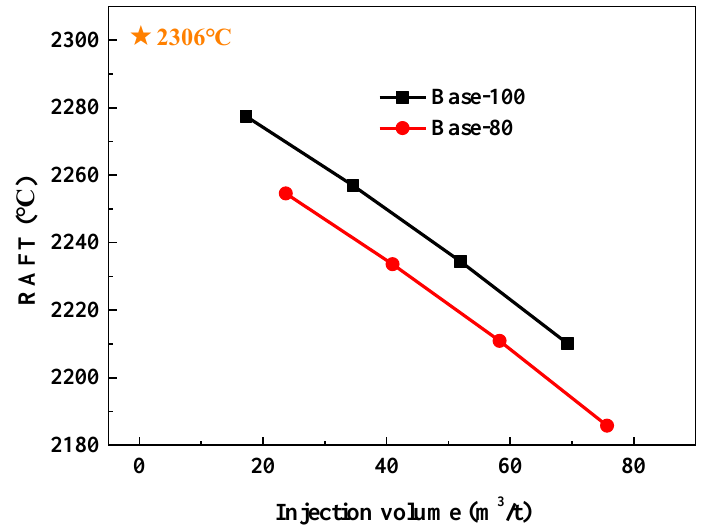
Figure 6. RAFT under different acceptable quantities of NG.